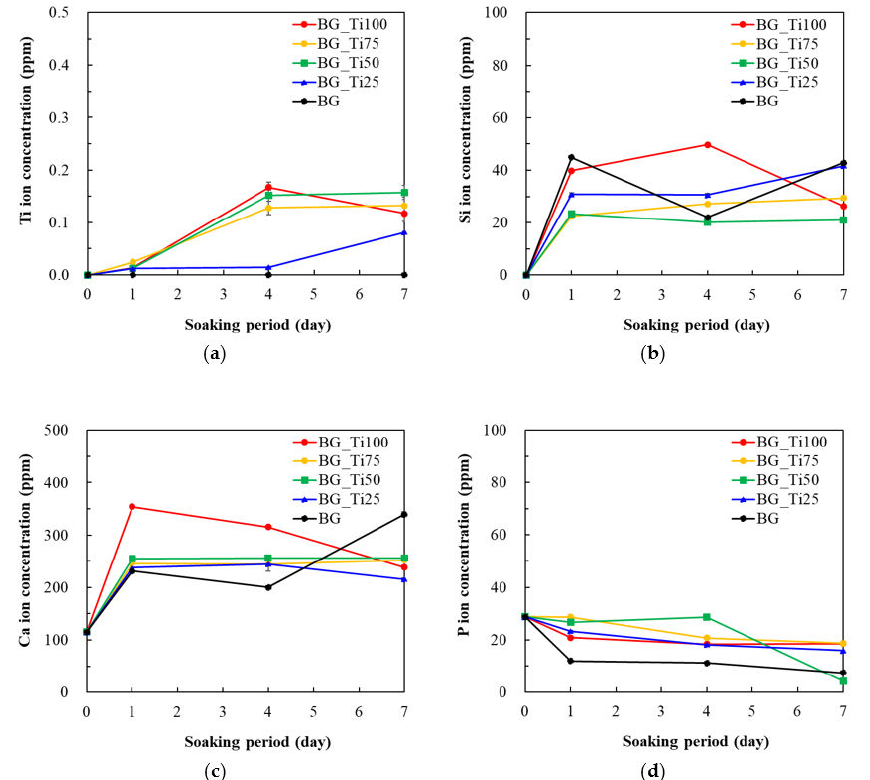
Figure 4. The ions released into SBF after the immersion of bioceramics composed of silica and titanium oxide with various concentrations of titanium oxide for 7 days, measured using ICP-MS. ( a ) Ti ion concentrations; ( b ) Si ion concentrations; ( c ) Ca ion concentrations; and ( d ) P ion